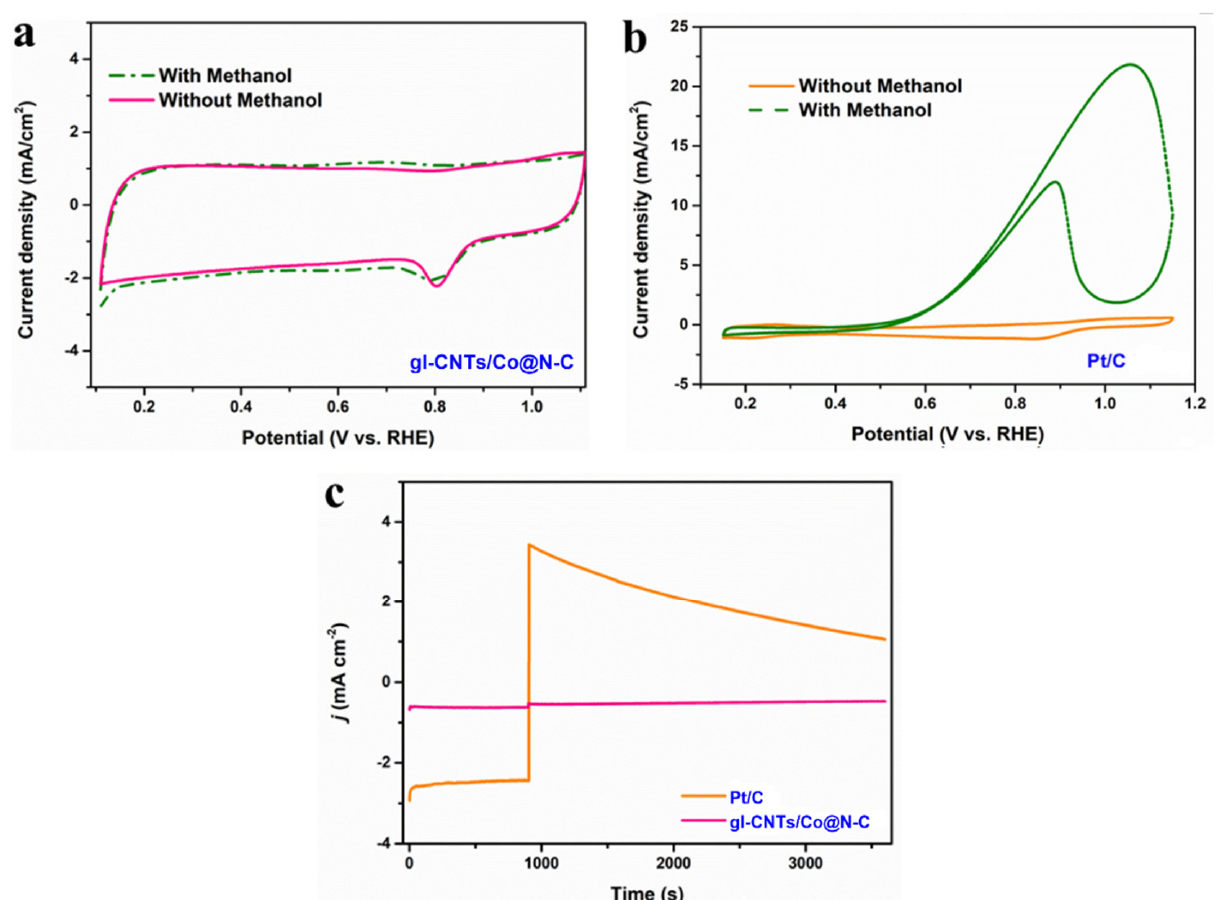
Figure 5. ( a ) CV curves of gl-CNTs/Co@N-C with and without 0.5 M methanol in 0.1 M KOH; ( b ) CV curves of Pt/C with and without 0.5 M methanol in 0.1 M KOH; ( c ) Chronoamperometric responses to compare gl-CNTs/Co@N-C and Pt/C with methanol.